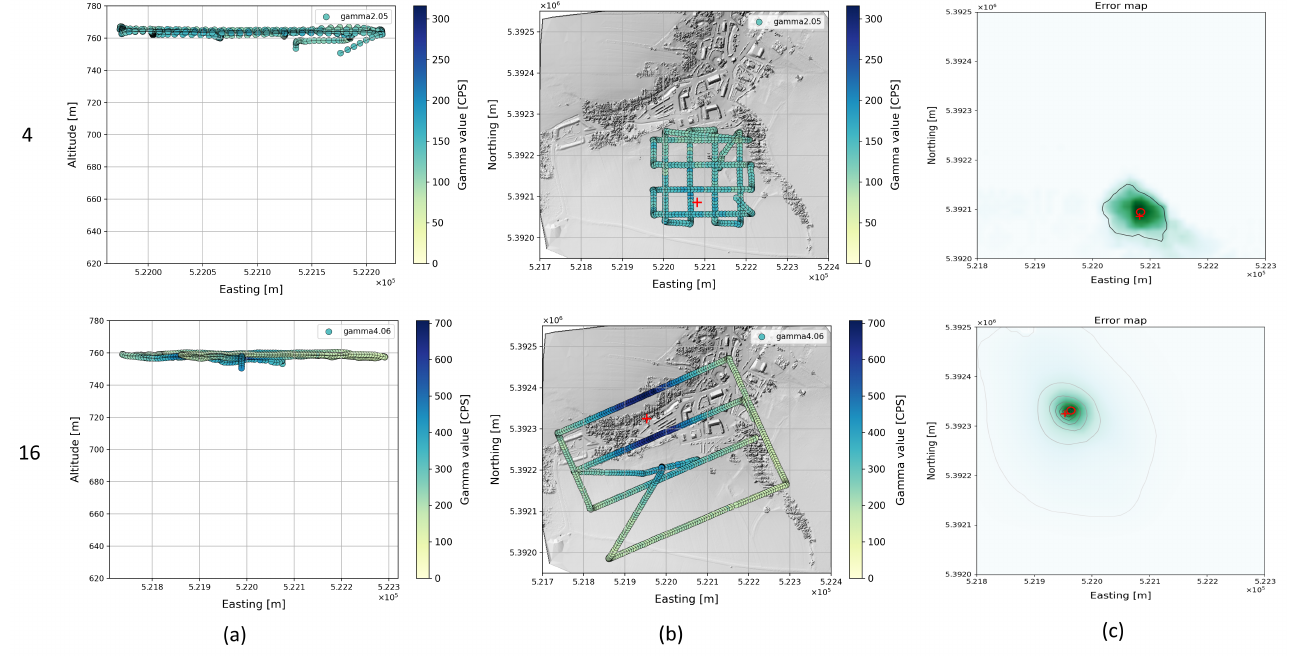
Figure 8. Flight pattern without climb and descent for selected flights (4, 16) with single radioactive source projected to xz-plane ( a ) and projected to ground xy-plane ( b ). The gamma measurements are color-coded. The corresponding cost map is shown in ( c